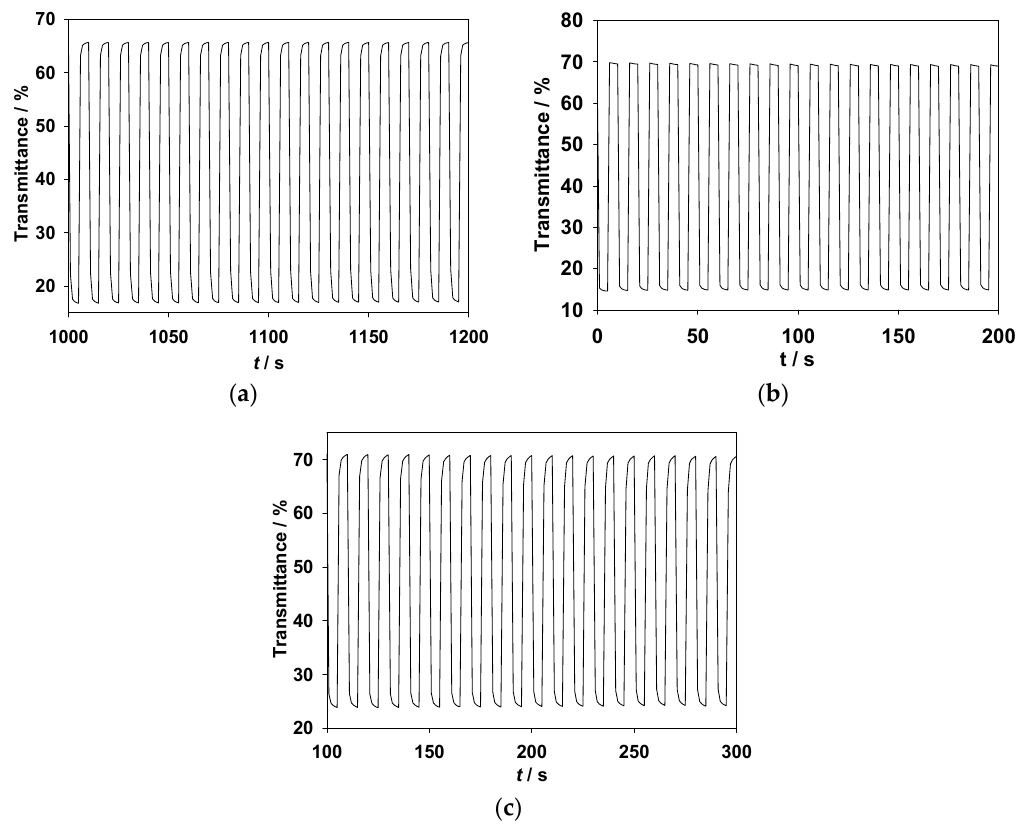
Figure 10. In situ transmittance of ( a ) P(MPS- co -TTPA)/PProDOT-Et 2 ; ( b ) P(MPO- co -TTPA)/ PProDOT-Et 2 ; and ( c ) P(ANIL- co -TTPA)/PProDOT-Et 2 ECDs as a function of time, with the time interval of 5 s. The ECDs were stepped by repeated potential between − 0.4 and +1.4 V.